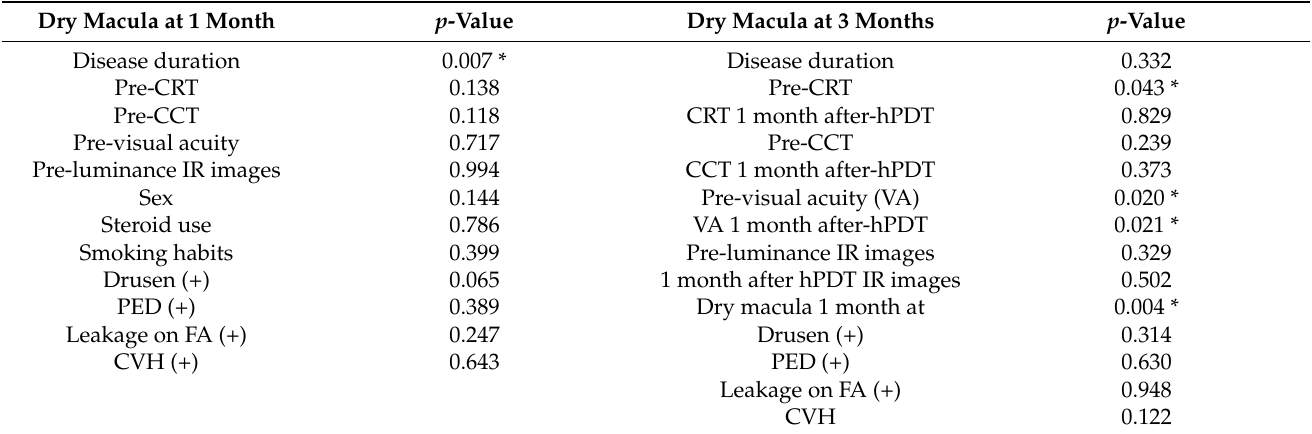
Table 3. Prognostic Factors Related to Dry macula at1 and 3 months after